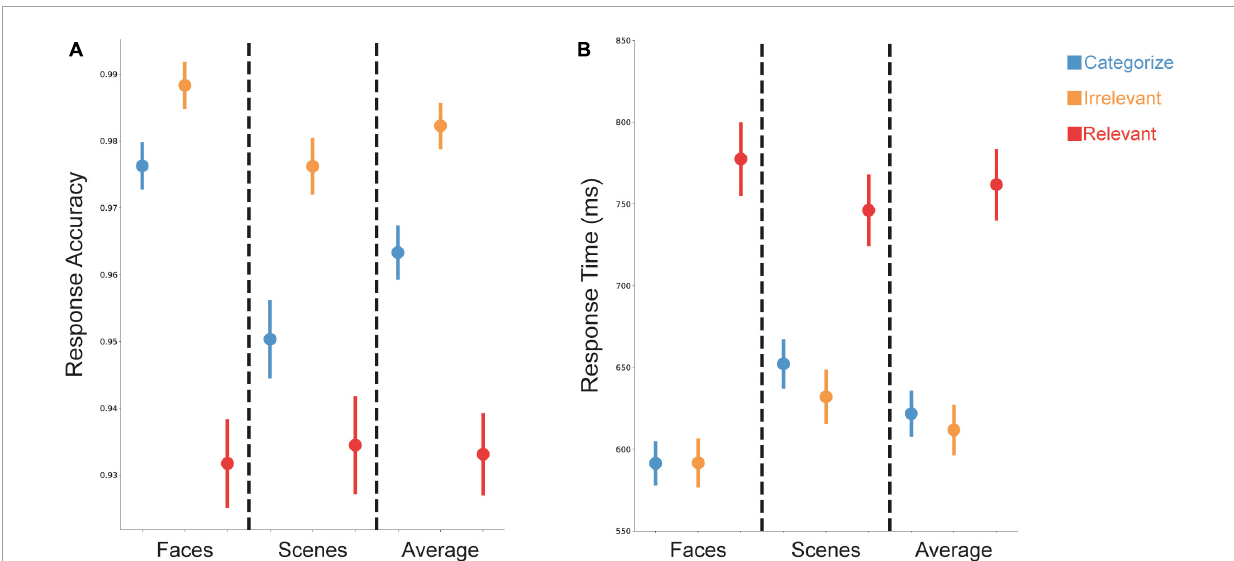
FIGURE2 Changes in task performance based on stimulus goals. (A) Accuracy was lower for relevant (red) compared to irrelevant (orange) or categorized (blue) stimuli. (B) Response time (RT) was slower for trials with relevant stimuli (red) compared to trials with irrelevant (orange) or categorized (blue) stimuli. Data are presented as mean ±